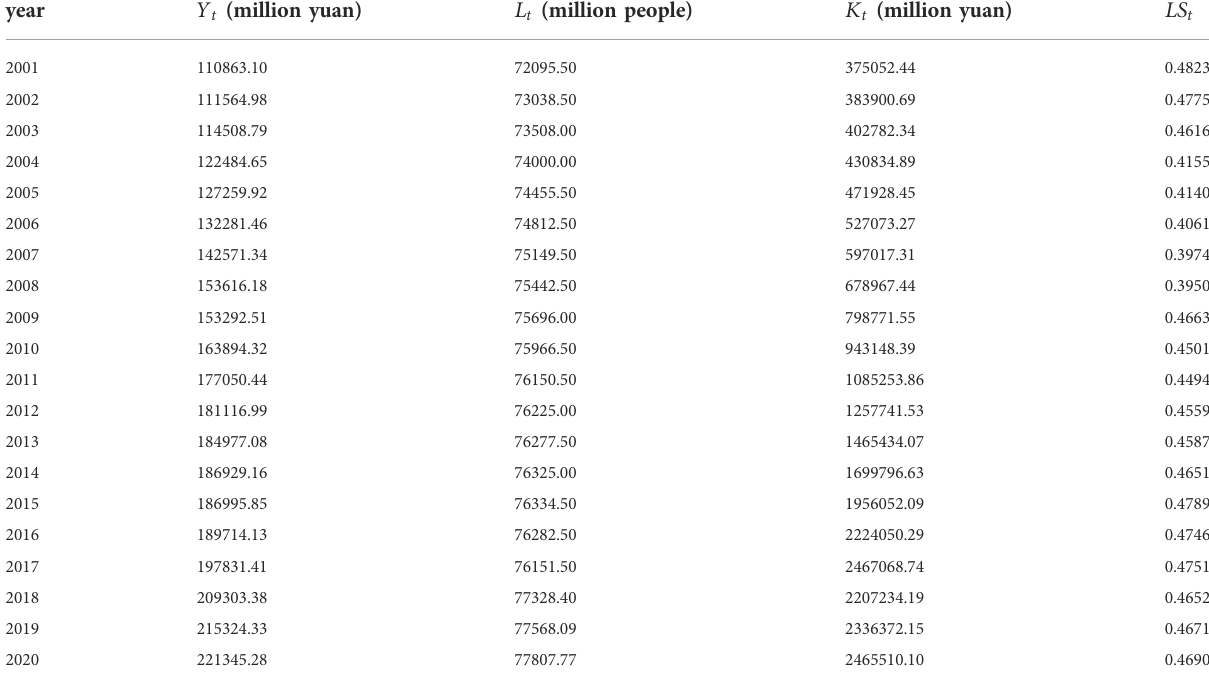
TABLE 2 Labor income share ( LS t